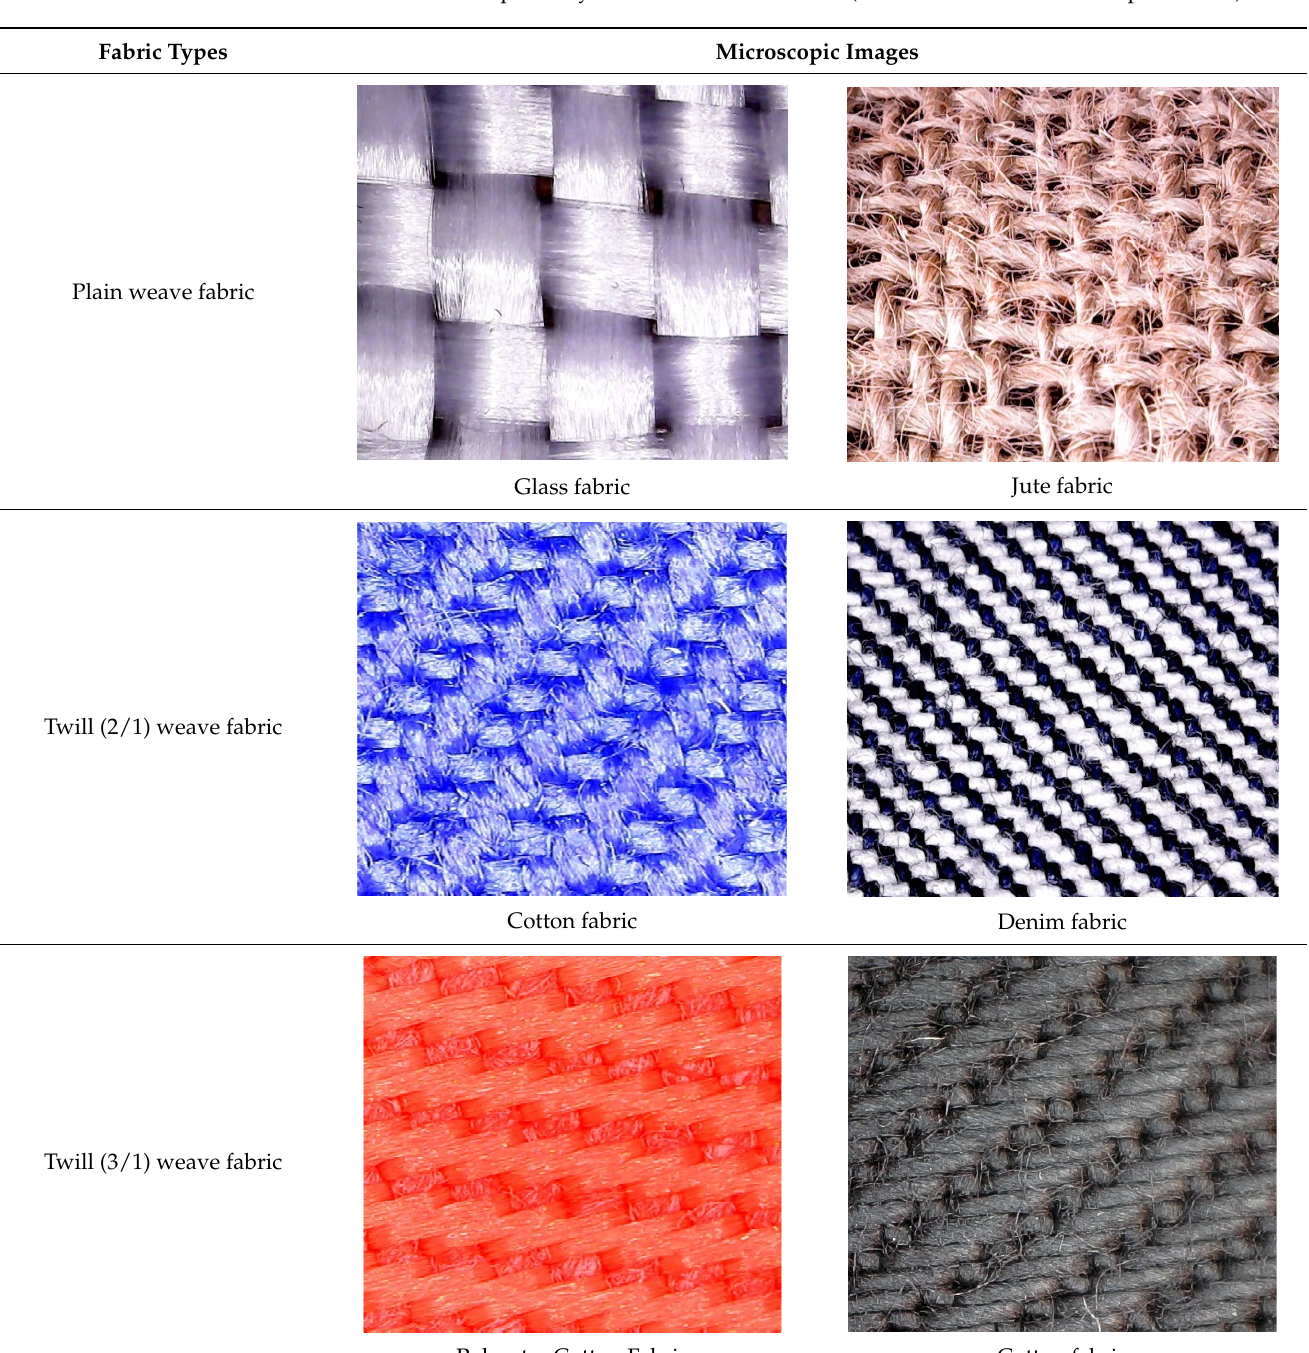
Table 5. Microscopic analysis of tested textile fabrics (vertical direction is the warp direction).